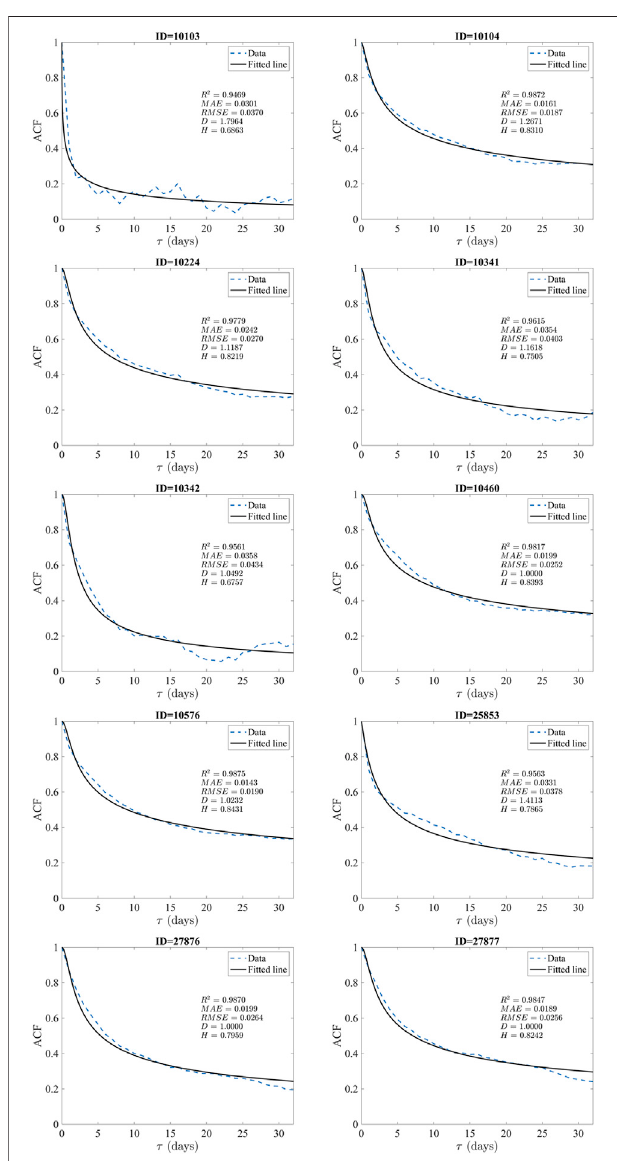
FIGURE4| Theempirical autocorrelationfunctionvalues(dashblueline) and the fi tted generalized Cauchy model (black line) for each of the 10 data